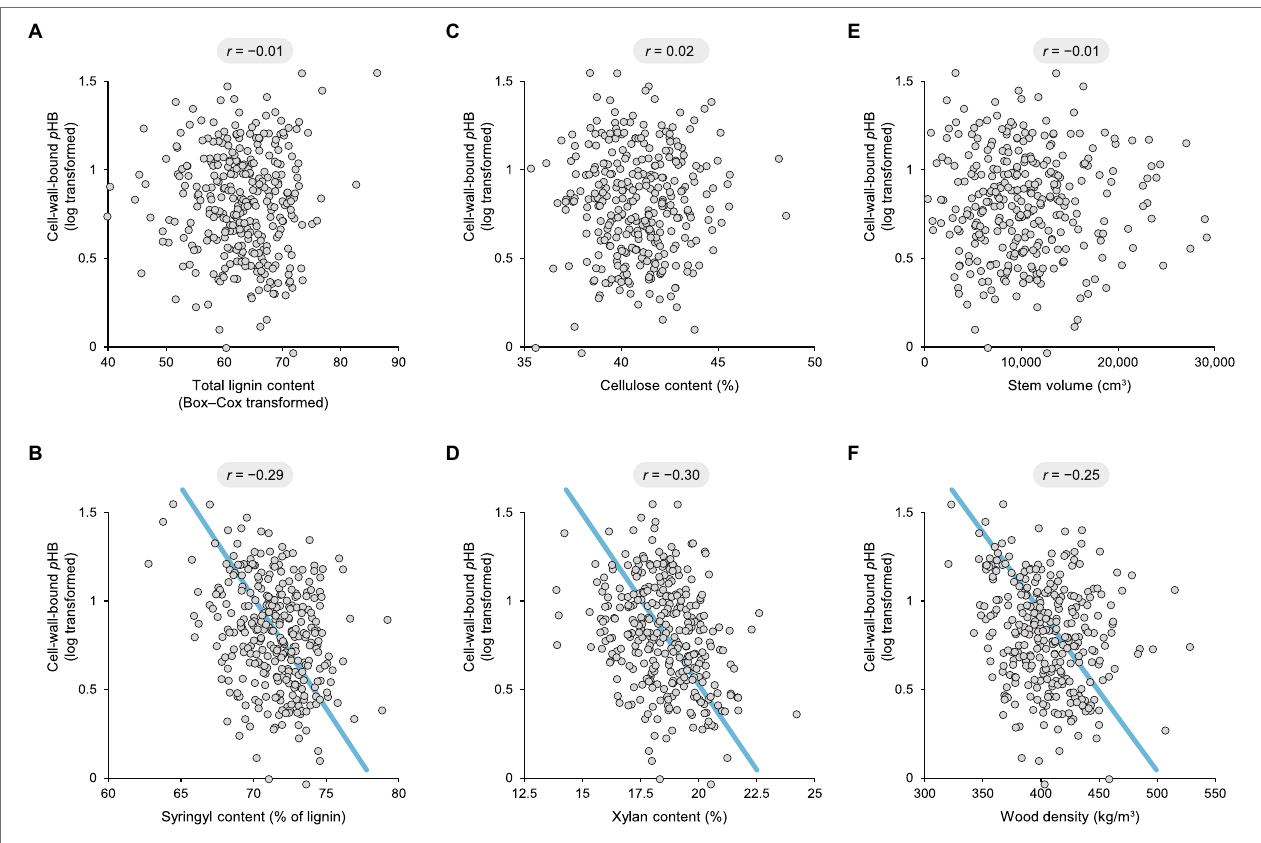
FIGURE 2 | Scatterplots depicting pairwise correlations between cell-wall-bound p -hydroxybenzoate and total lignin content (A) , syringyl content (B) , cellulose content (C) , xylan content (D) , stem volume (E) , and wood density (F) in a collection of 316 9-year-old unrelated genotypes of Populus trichocarpa grown in a common garden. The r values provided above each plot are Pearson’s correlation coefficients. The blue lines depict reduced major axis regressions. Syringyl content, cellulose content, xylan content, stem volume, and wood density were normally distributed, whereas the datasets for cell-wall-bound p HB and total lignin content were transformed to meet the conditions of